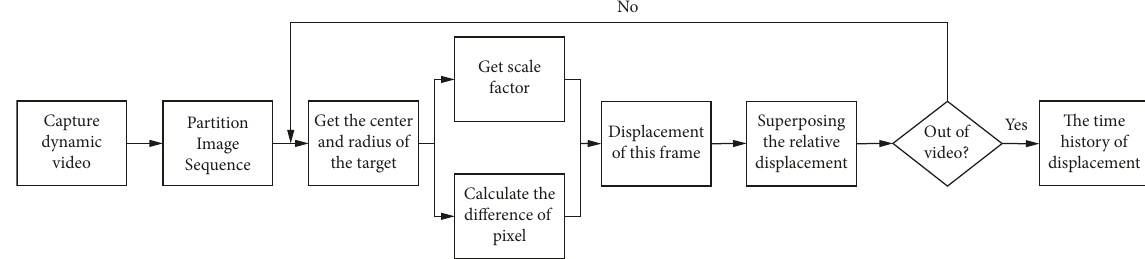
Figure 3: Dynamic displacement detection process of isolation